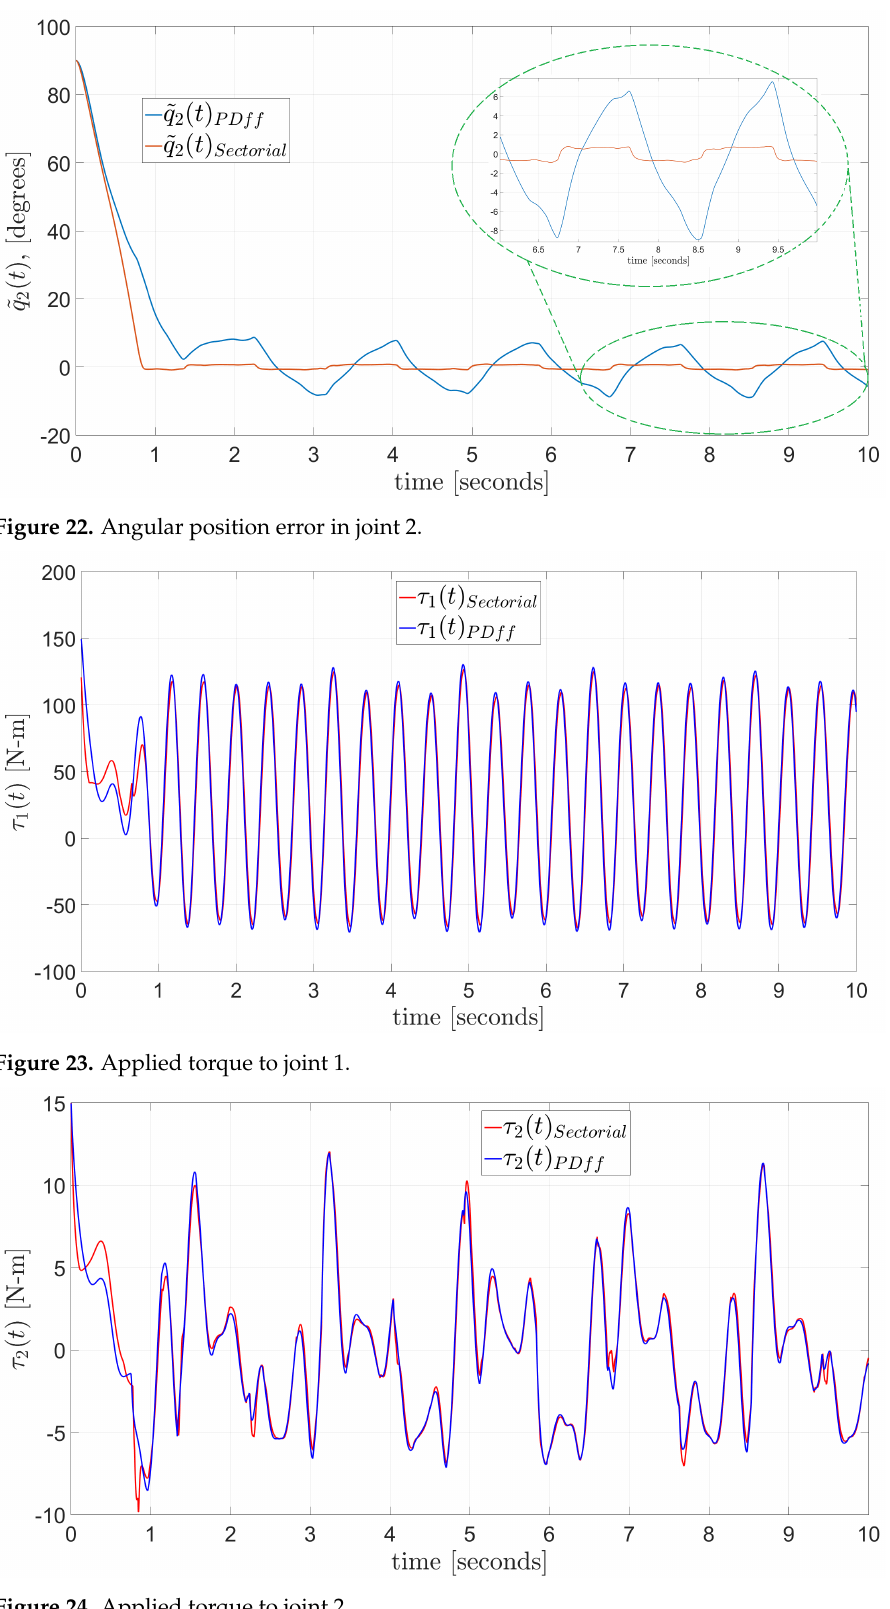
Figure 24. Applied torque to joint